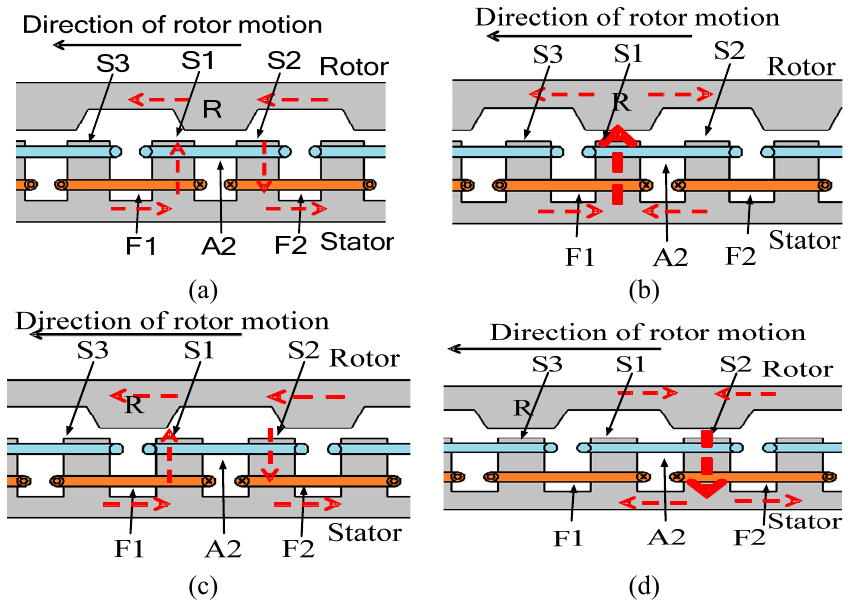
Figure 1. The structure of a flux-switching motor.